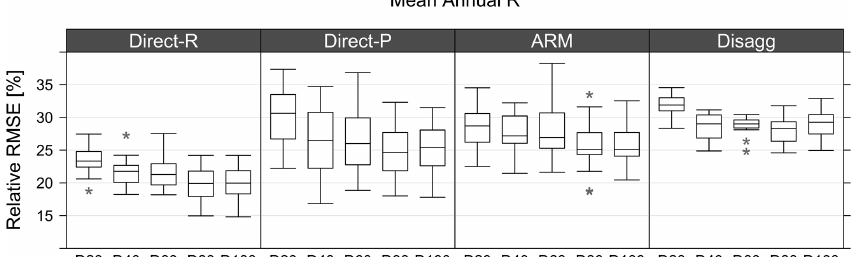
Figure 8. Pearson’s correlation coefficient, relative bias, and relative RMSE results for the four tested methods. Box plots show the relevant statistic for the 20 realisations ( N = 20) at each density scenario (e.g. D20 corresponds to the 20% station density